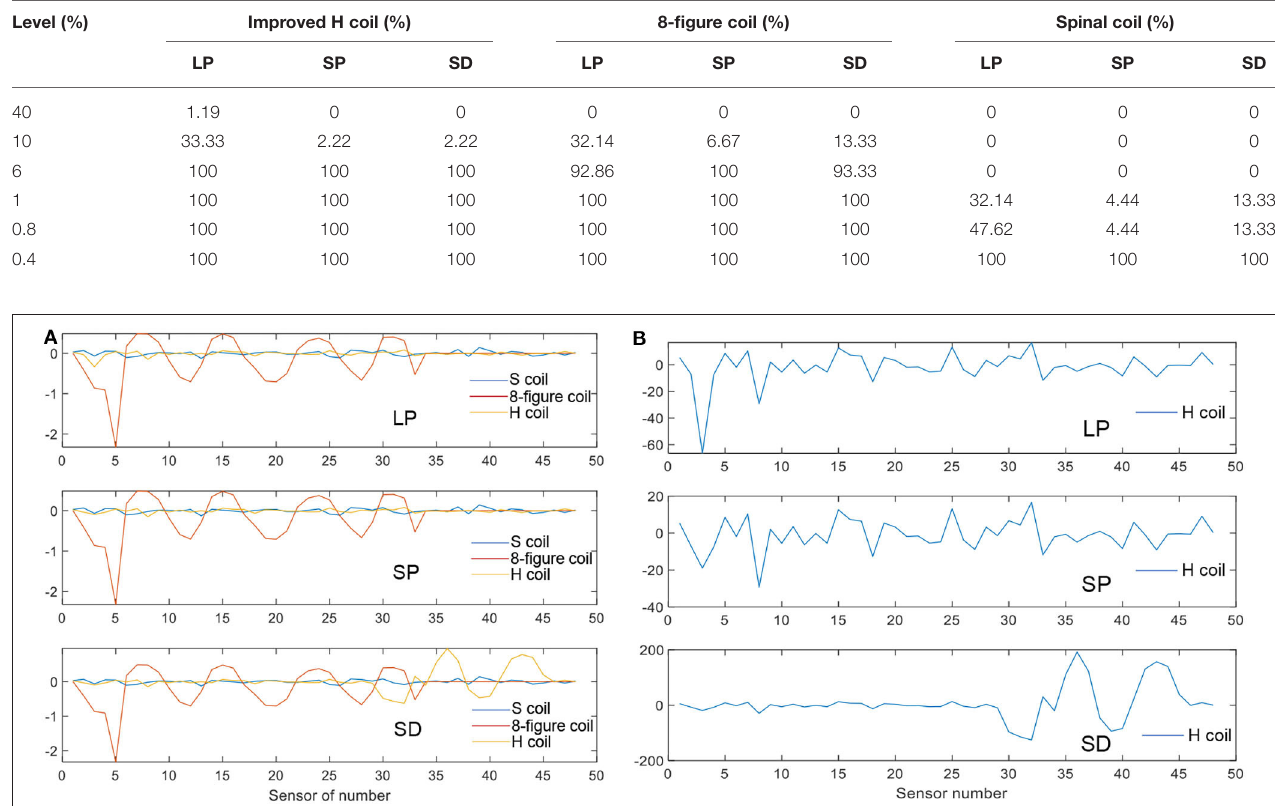
TABLE 2 | The mass of stroke stimulated of the three coils.